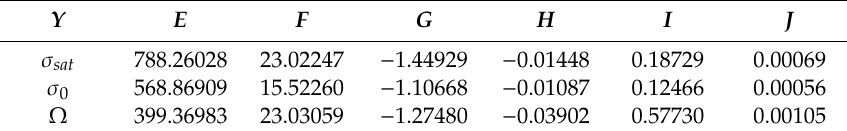
Table 6. The coefficients of Equation (23) about Table 6. The coe ffi cients of Equation (23) about σ sat , σ 0 and Ω .